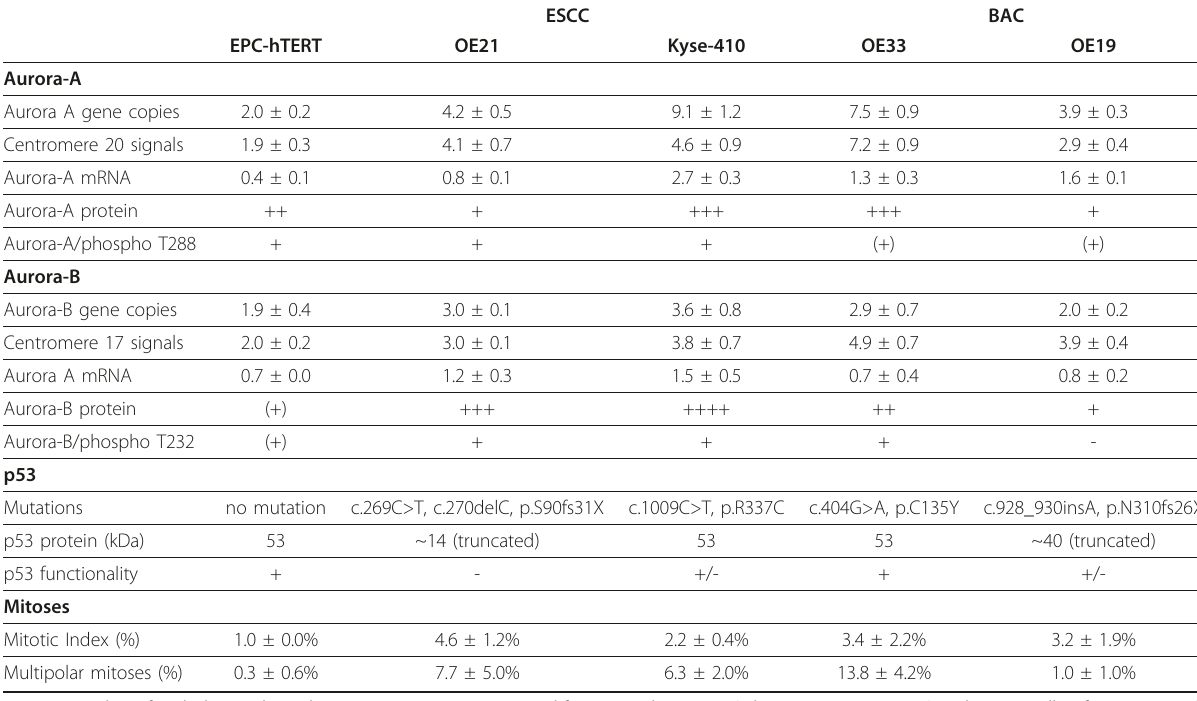
Quantitative data of each three independent experiments are summarized for FISH and q-RT-PCR (relative mRNA expression) analyses as well as for mitoses and multipolar mitoses (mean and ± standard deviation). Immunoblot analyses are depicted with minus (-) to increasingly positive (+ to ++++) protein expression. Identified p53 mutations and associated effects are